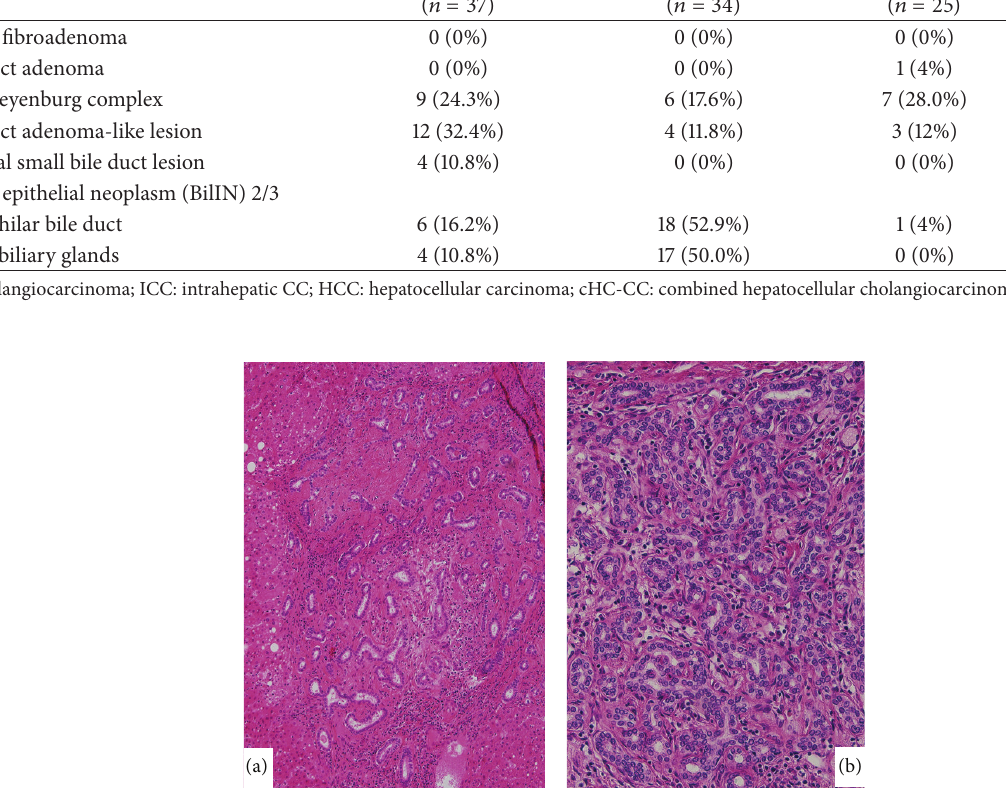
Figure 4: Bile duct adenoma-like lesion. (a) Small nodule composed of abundant interlobular bile ducts and fibrous stroma is found in the deep part of the liver. HE. (b) Small nodule of dense small interlobular bile ducts is found in the deep part of the liver.